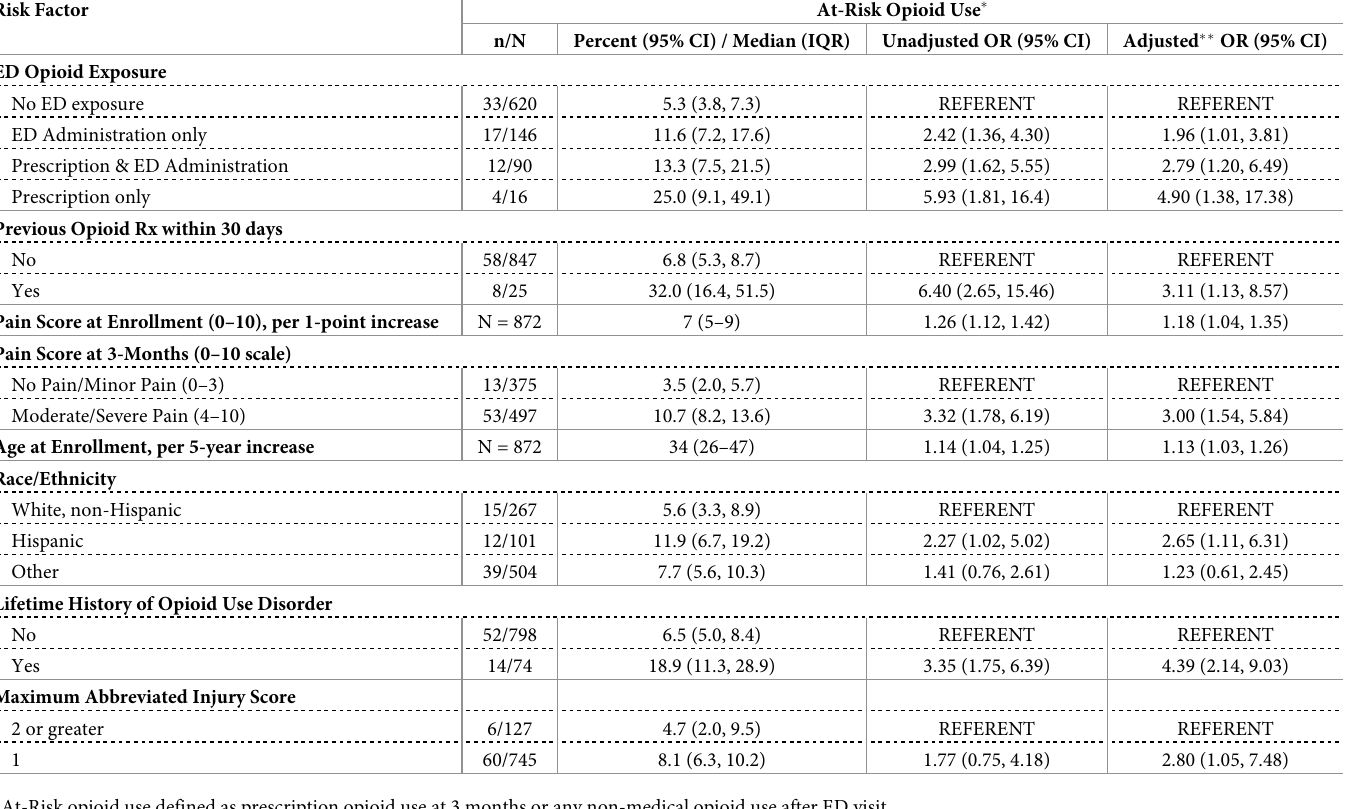
� At-Risk opioid use defined as prescription opioid use at 3 months or any non-medical opioid use after ED visit. �� Adjusted for all variables in table; Hosmer-Lemeshow GOF p-value = 0.84; calibration belt p-value = 0.49; area under the receiver operating characteristics curve = 0.793 (95% CI: 0.740,